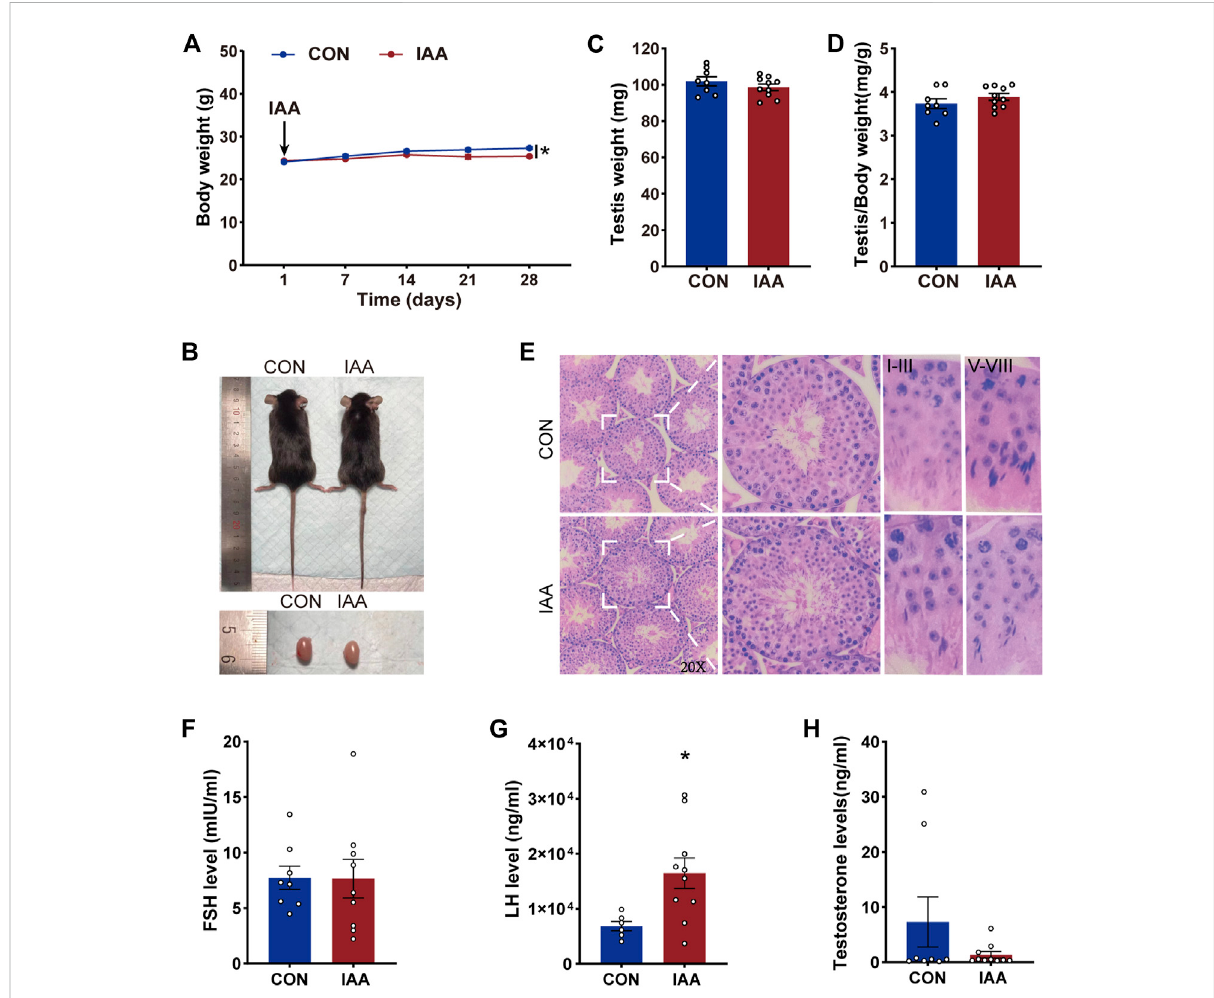
Effects of IAA exposure on general condition and serum hormone levels in mice. During the IAA exposure, the body weights of the mice were recorded twice a week. Only weekly values are shown inthe graph (A) . Pictures of mice and testis (B) , testicular weight (C) , and therelativeweightof testis (D) between the two groups were recorded after sacri fi ce. Hematoxylin-eosin (H&E) sections of testicular tissue of mice were also recorded andthepathological morphologywasobserved (E) .After IAAexposure, serumFSH,LH, andtestosteronelevelsofmiceweredetected byELISA (F – H) . Data are presented as the mean ± SEM. * Signi fi cant differences compared to control ( p <